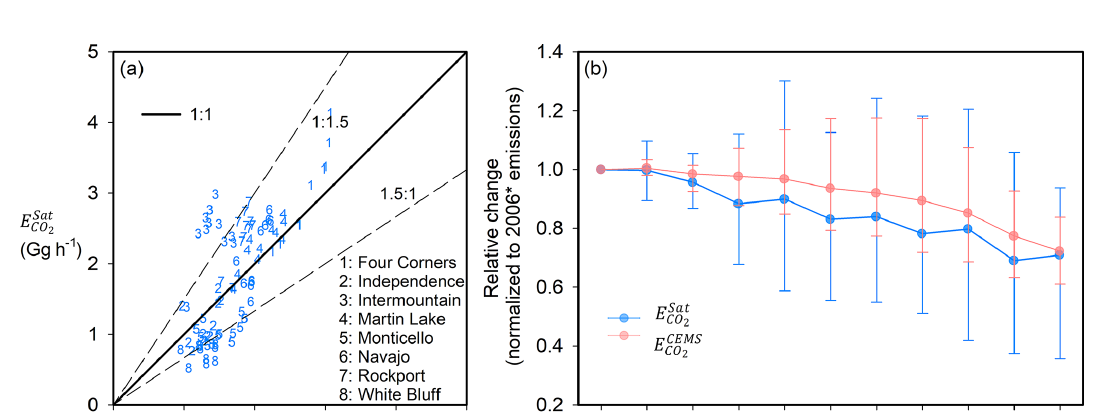
Figure 7. (a) Scatterplot of E Sat for eight power plants, as compared to E CEMS CO 2 of 1 : 1. The dashed lines represent the ratios of 1 : 1 . 5 and 1 . 5 : 1, respectively. (b) Interannual trends of the averaged E Sat E CEMS (pink lines) are for all power plants analyzed in this study from 2006 ∗ to 2016 ∗ , as normalized to the 2006 ∗ value. The whiskers CO 2 denote the maximum and minimum